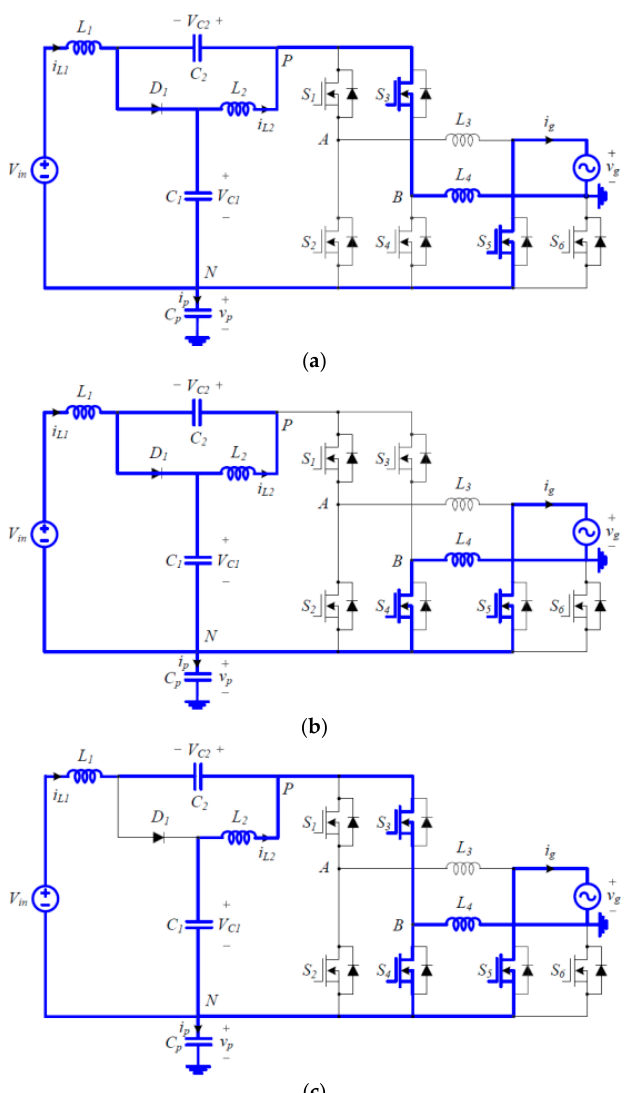
Figure 4. Switching circuit diagrams of the proposed inverter for a negative grid cycle: ( a ) powering state; ( b ) freewheeling state; ( c ) shoot-through state.